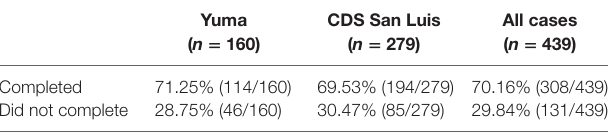
TaBle 3 | Dichotomous treatment outcome (completed versus did not complete).